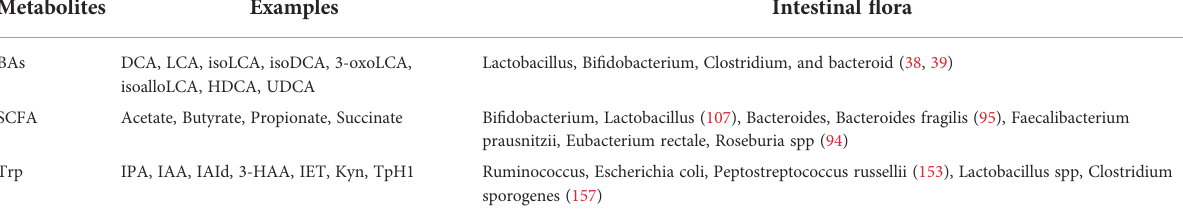
TABLE 1 Major gut microbial metabolites produced or modi fi ed by the bacteria.